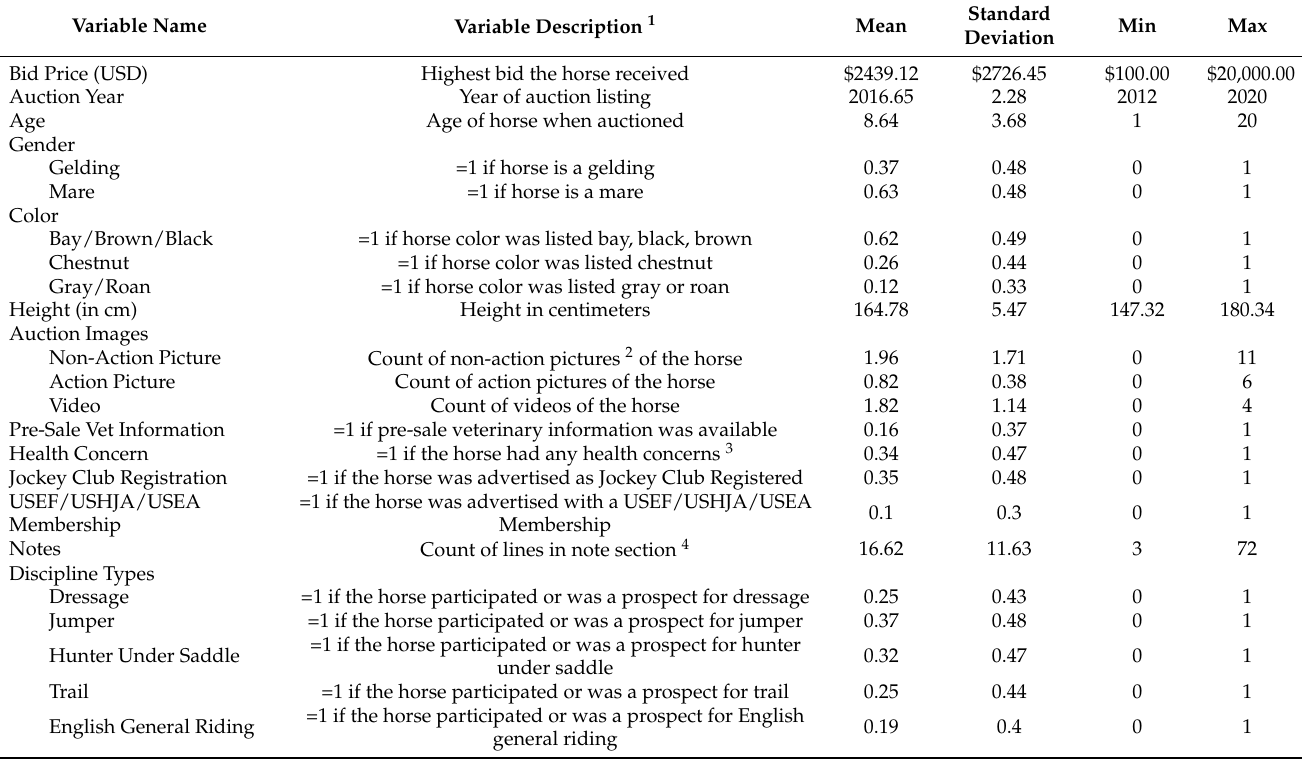
Table 1. Thoroughbred Online Auction Data Description and Summary, 2012–2020 (n =